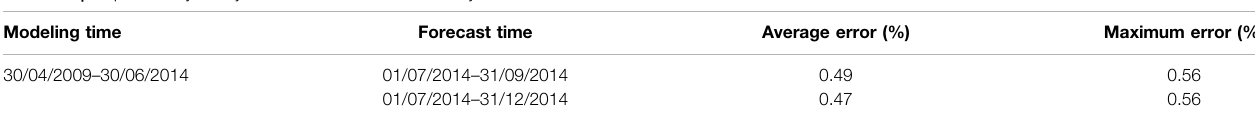
TABLE 6 | Slope stability safety coef fi cient simulation accuracy